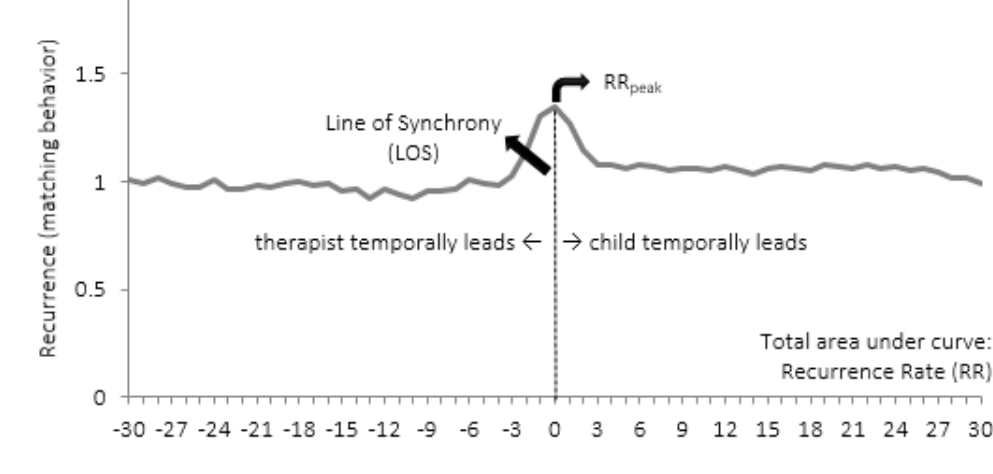
Figure 1. Average Diagonal Cross-Recurrence Profile (DCRP) plot of the first session, with an indication of the Line of Synchrony (LOS), Recurrence Rate (RR), and RR peak . The Q los measure can be calculated by dividing the proportion of recurrence on the left side of the LOS by the proportion of recurrence on the right side.